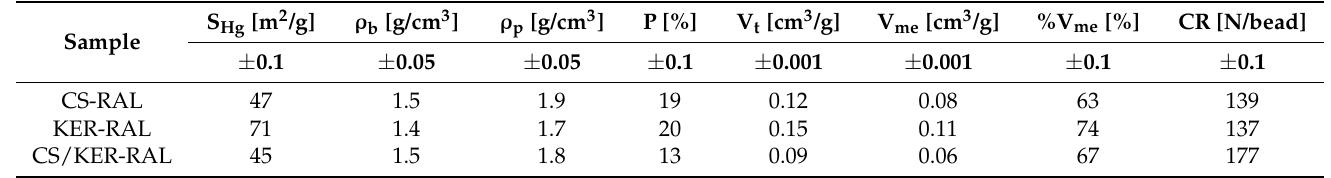
Table 1. Porosity results of CS-RAL, KER-RAL, and CS/KER-RAL beads measured by the Hg intrusion technique.